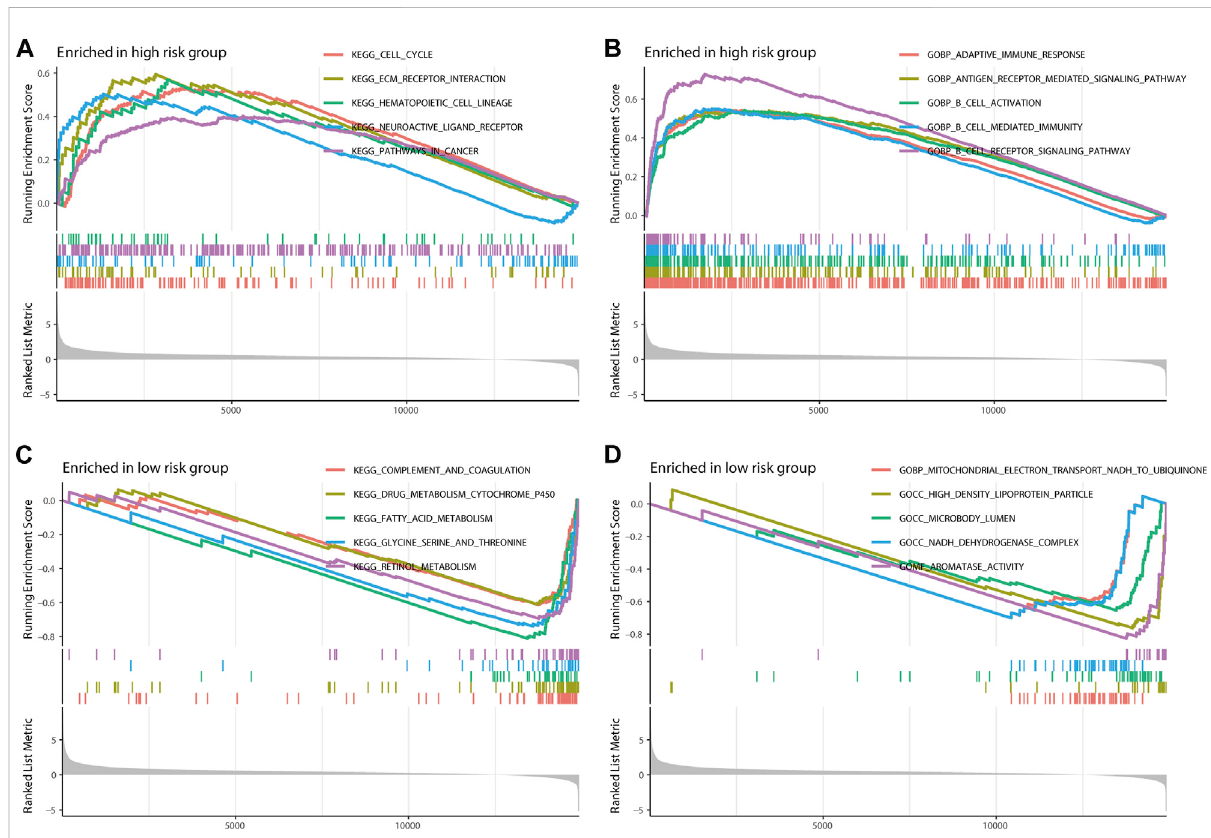
FIGURE 9 Gene Set Enrichment Analysis. The top fi ve pathways in two different risk groups by KEGG enrichment analysis (A,C) and GO enrichment analysis (B,D) . KEGG, Kyoto Encyclopedia of Genes and Genomes; GO, Gene